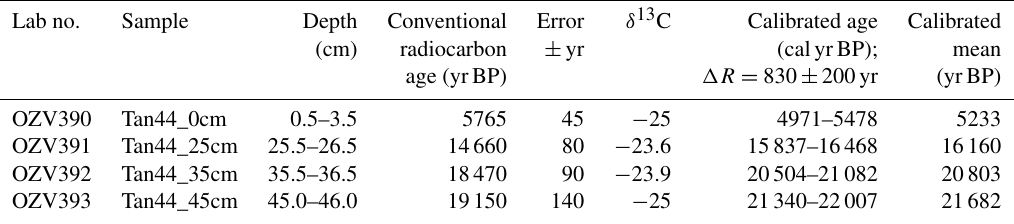
Table 2. Radiocarbon dating (AIOM) conventional and calibrated results. Lab